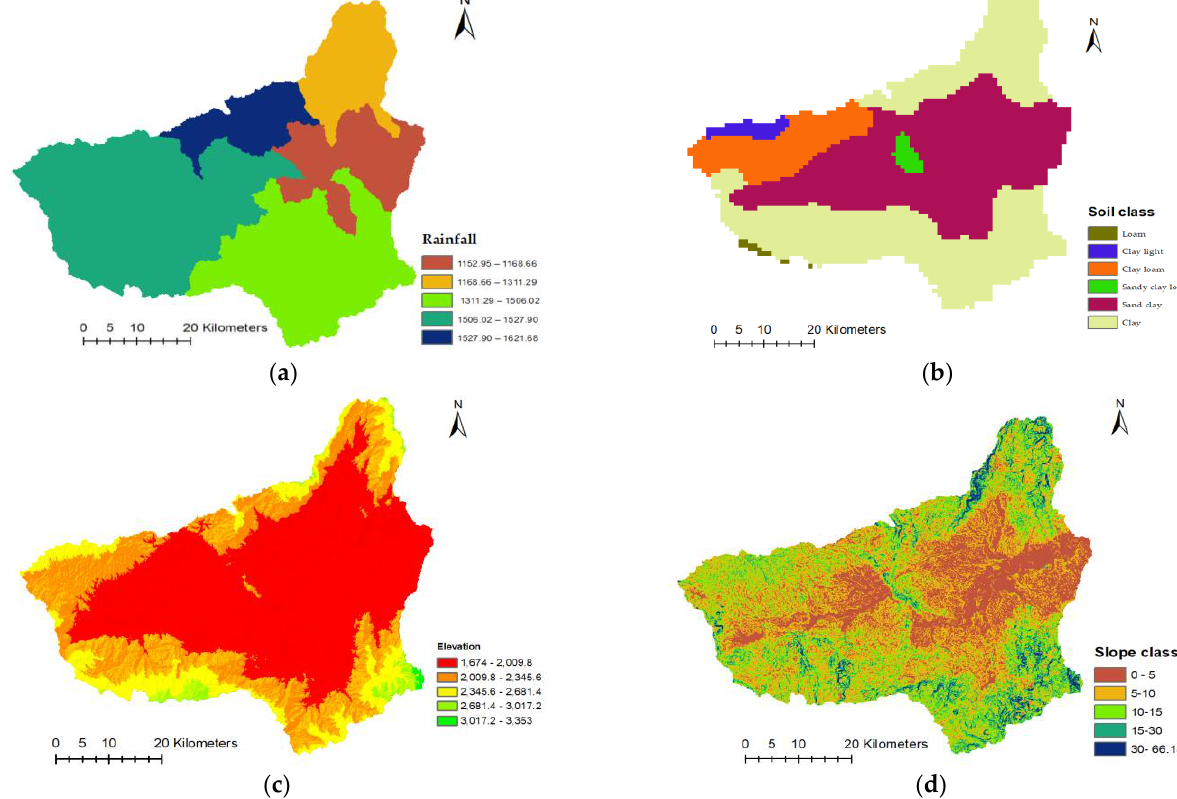
Figure 3. Thematic map of ( a ) Rainfall, ( b ) Soil, ( c ) Elevation, ( d ) Slope.